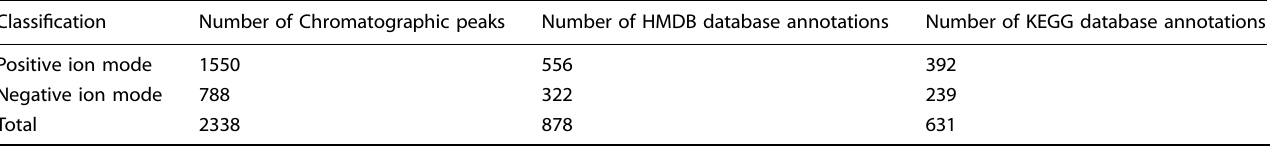
Table 2. Summary of metabolite identi fi cation and classi fi cation annotation results. Classi fi